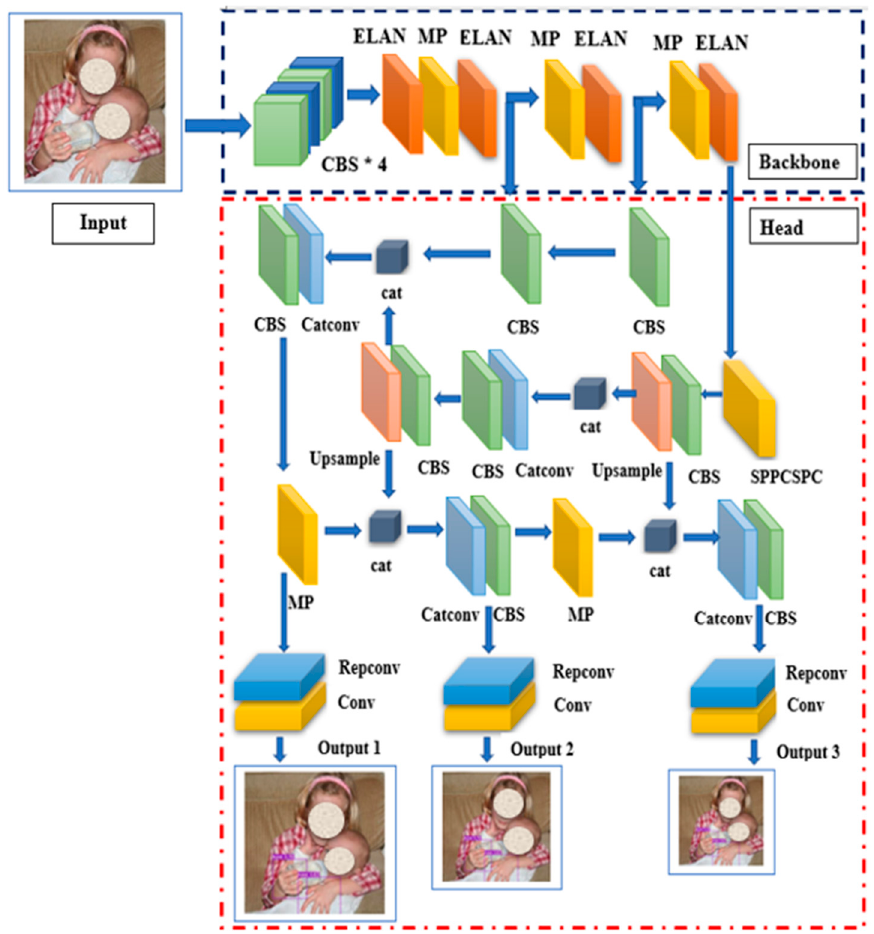
Figure 1. Yolov7 architecture. Source: The human faces in the figures are all from public datasets (Oxford Hand Dataset).